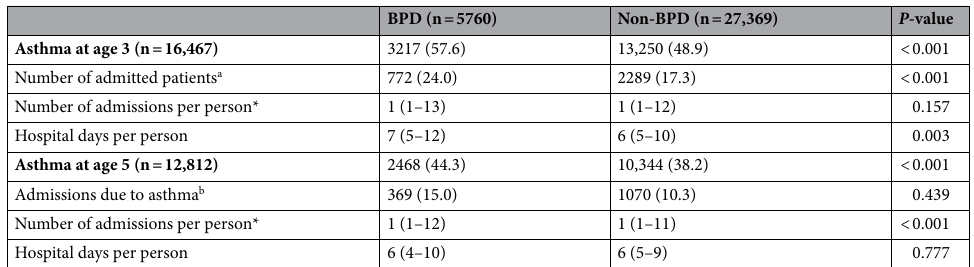
Table 3. Asthma patients categorized per BPD status. Data are expressed as n (%), median (interquartile range), or median (range)*. a Between 36 and 48 months of age. b Between 60 and 72 months of age. The percentage of patients with asthma at ages 3 and 5 was calculated using the total number of patients alive at ages 3 and 5. BPD bronchopulmonary dysplasia.